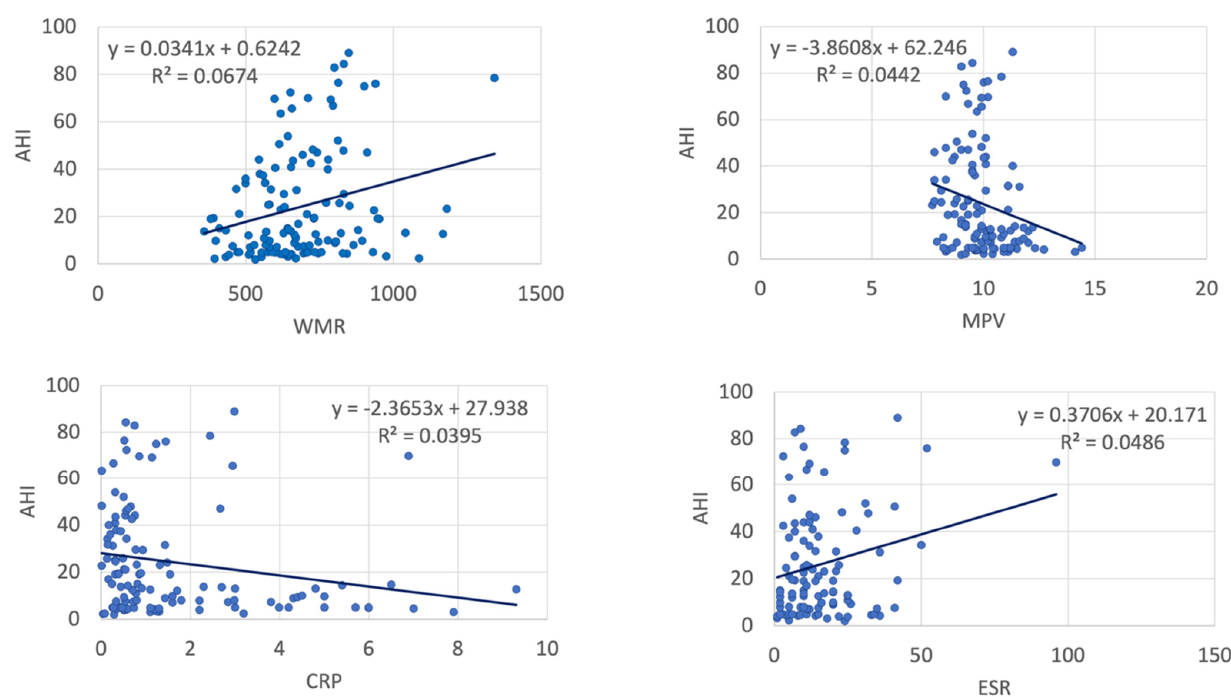
Figure 2. Correlations between AHI and inflammatory markers (123 patients, controls and OSA) (AHI: apnea–hypopnea index, MPV: mean platelet volume, CRP: C-reactive protein, ESR: erythrocyte sedimentation rate). Table 3. Anthropometric and inflammatory parameters, at baseline and after 8 weeks of CPAP (moderate and severe